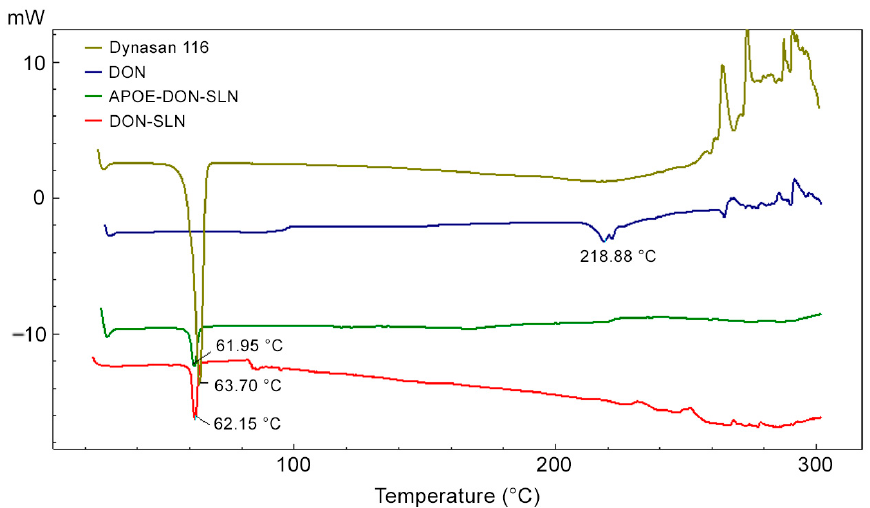
Figure 3. DSC thermograms of dynasan 116, donepezil HCl (DON), non-targeted (DON-SLN), and targeted SLNs (APOE-DON-SLN).